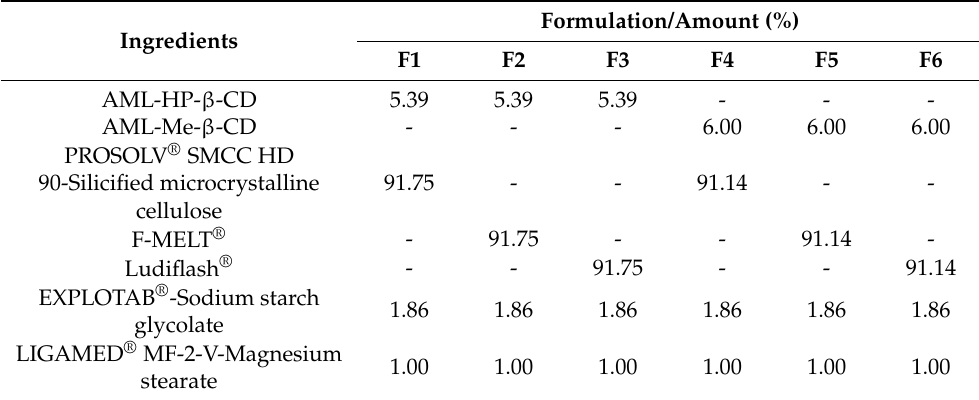
Table 1. The compression material